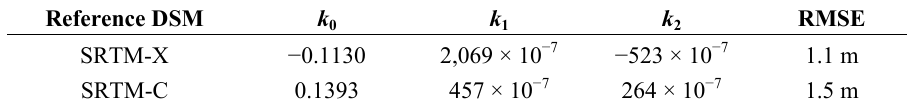
Table 1. Correction factors for phase offset and phase ramp errors (radians), see Equation (1), and the final accuracy (RMSE) for the 25 Ground Control Points